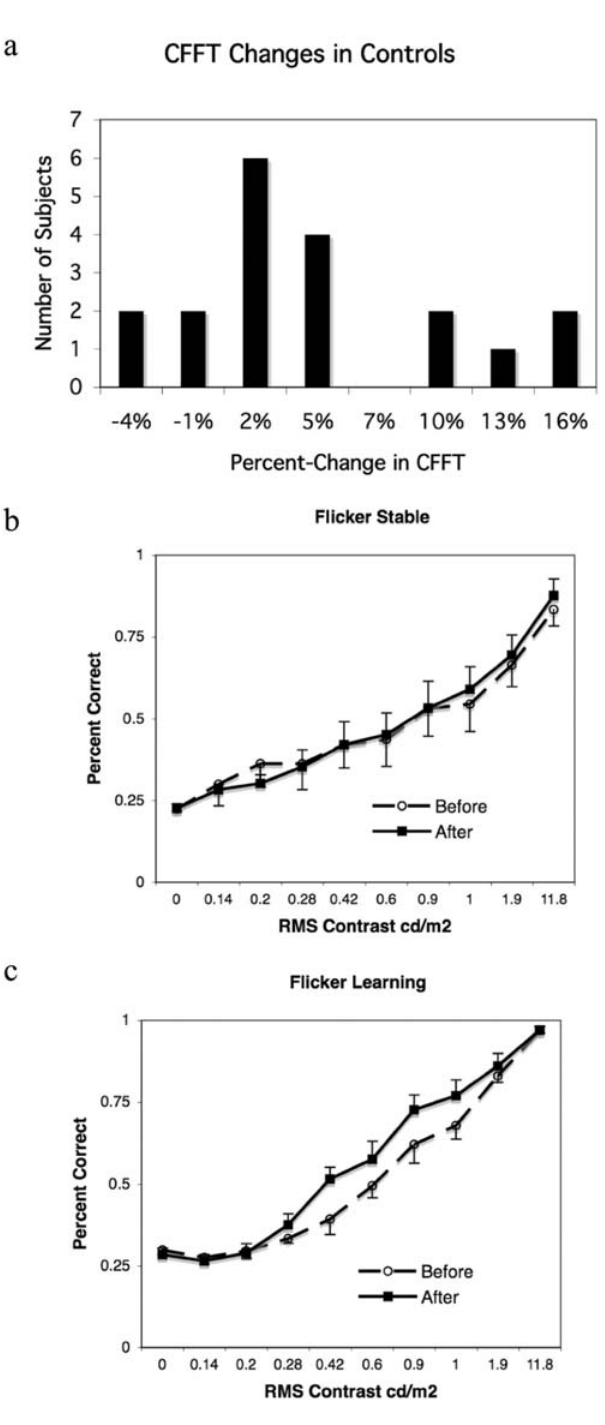
Figure 5. CFFT increases and motion-direction sensitivity for control groups. a, Histogram of percent-change in CFFT for subjects in the No- Motion, No-Coherence, N-Back and N-Back-0% Groups. b, performance averaged across directions for Flicker-Learning subjects on pre-test (dashed-line) and post-test (solid-line). b, performance averaged across directions for Flicker-Stable subjects on pre-test (dashed-line) and post- test (solid-line). Error bars reflect standard-error. doi:10.1371/journal.pone.0000028.g005 cells in magnocellular brain areas, which are specialized for